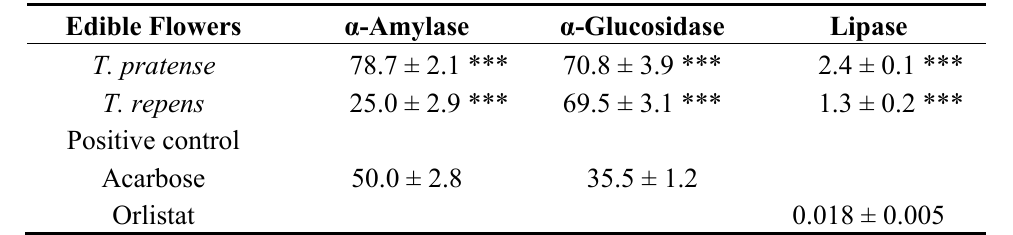
Table 3. Inhibitory activity (IC 50 (μg/mL)) of T. pratense and T. repens extract against key enzymes linked to diabetes and